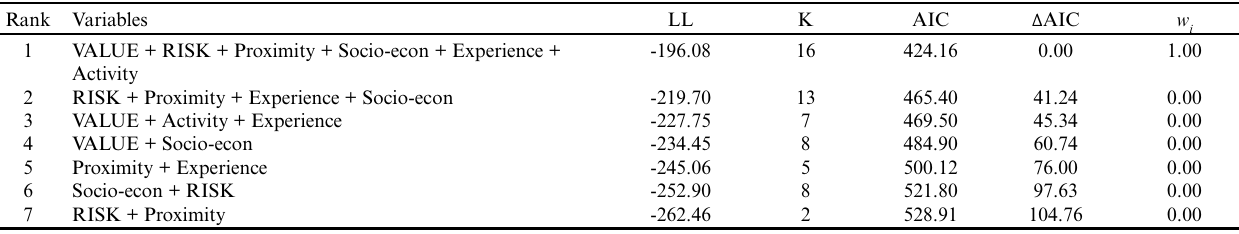
Table 4 . Ordered generalized logistic models used to describe tolerance for coexisting with cougars in Clearwater County, Alberta. Model log-likelihood (LL), number of estimated parameters (K), Akaike’s information criterion (AIC), AIC difference ( Δ AIC), and AIC weight (wi) are displayed.